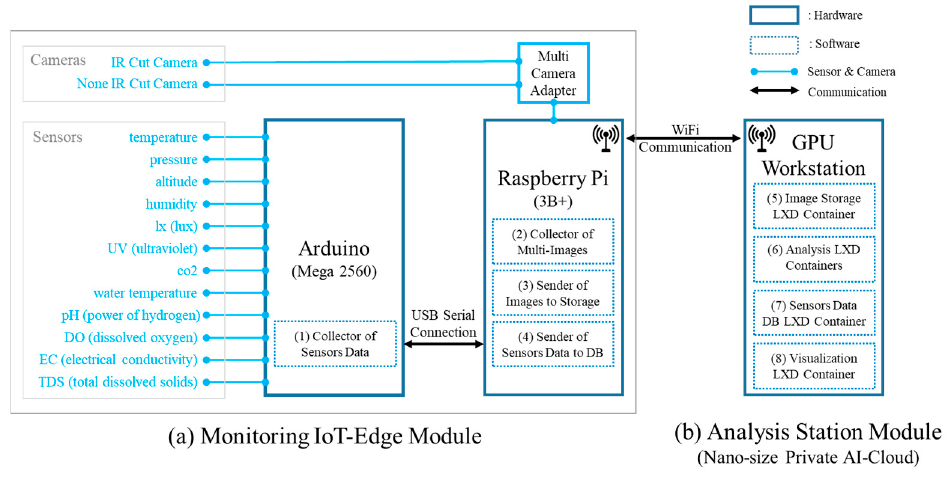
Figure 2. The system module